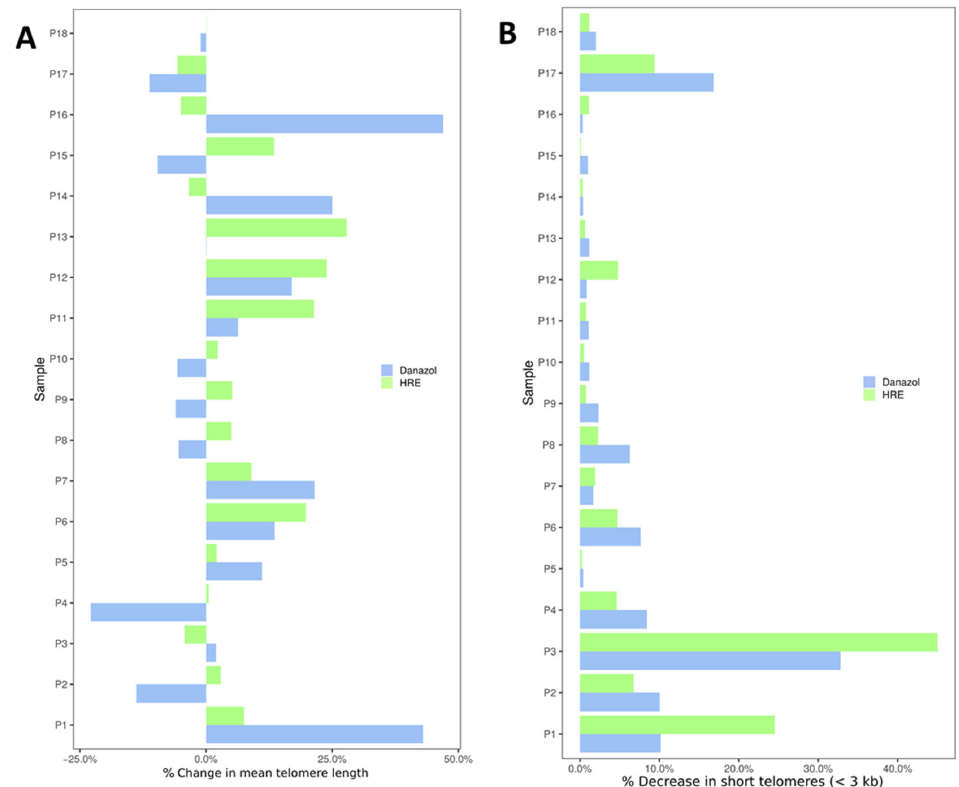
Figure 6. Changes in telomere length in circulating lymphocytes from each healthy donor after exposure to HRE and to danazol (1 µ g / mL). ( A ) Change in mean telomere length and ( B ) decrease in the proportion of lymphocytes showing drastic telomere shortening (<3 kb).